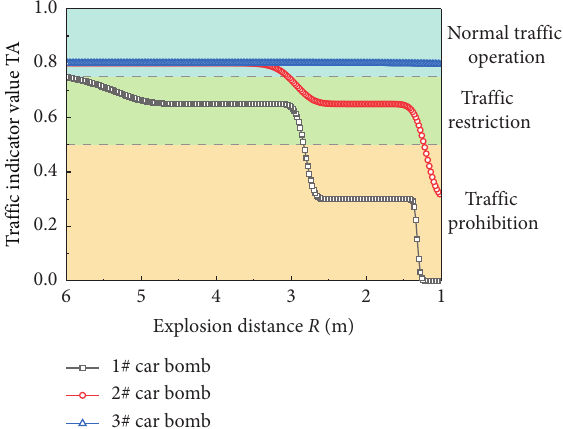
Figure 16: Explosion distance-traffic indicator value